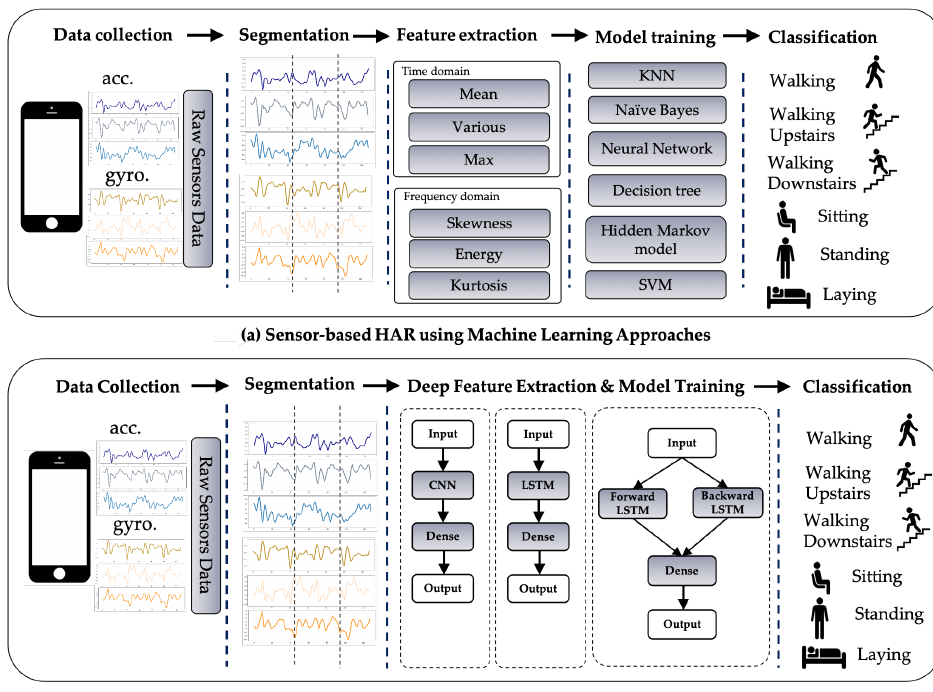
Figure 1. Sensor-based HAR approaches using ( a ) ML technique and ( b ) the DL